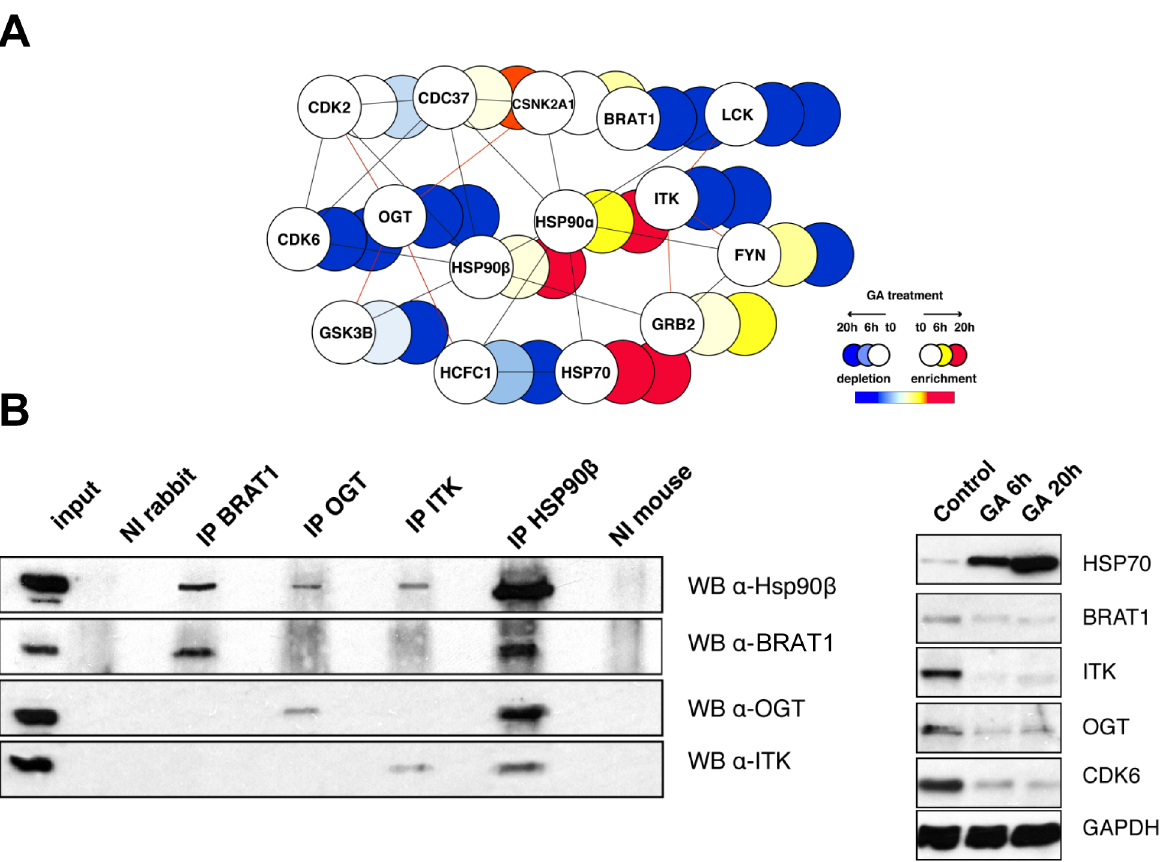
Figure 5. Validation of new Hsp90 clients. A ) Network analysis of a selected set of potentially new Hsp90 client proteins. stSILAC data and the Hsp90 interaction network Hsp90Int [21] were combined to identify interesting candidates (OGT, ITK and BRAT1) with no reported interactions with Hsp90 at the time of the analysis. Edges connecting candidate proteins with known Hsp90 interacting proteins are highlighted in red. B ). Co- immunoprecipitation (co-IP) experiment demonstrating interactions between BRAT1, OGT and ITK with Hsp90 b in Jurkat cells. Equal concentrations of specific antibodies against BRAT1 (rabbit), OGT (rabbit), ITK (mouse), Hsp90 b (mouse), and the corresponding non-immune (NI) control antibodies from rabbit and mouse were used in co-IP experiments, and then analysed by immunoblotting (WB). C ) GA-induced degradation of BRAT1, ITK and OGT in Jurkat cells. Lysates from cells treated with GA or with the equivalent volume of the solvent DMSO (control) for 6 and 20 h were analysed by WB for these three mentioned proteins and also for Hsp70 and CDK6 as positive controls of GA action.